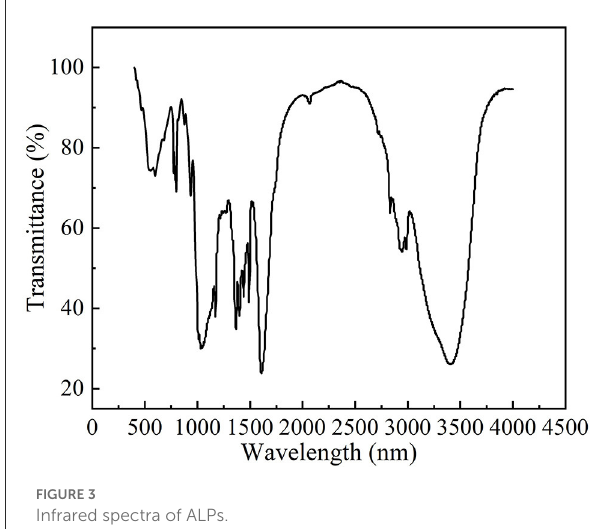
FIGURE3 Infrared spectra of